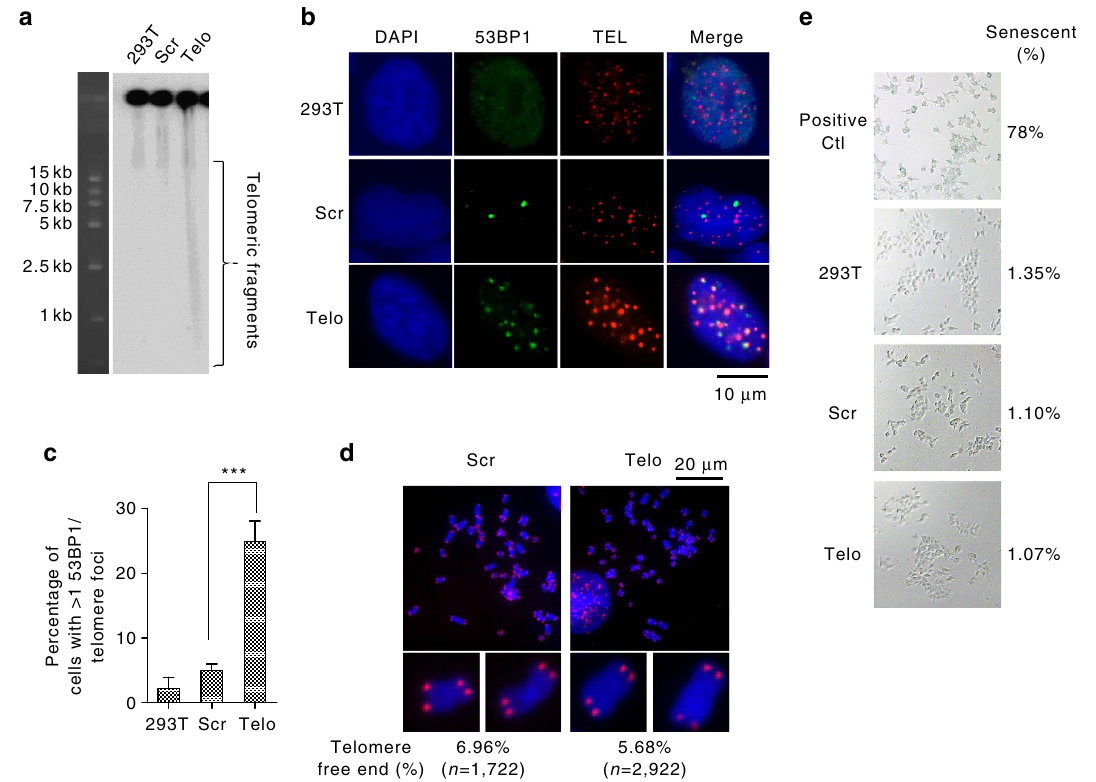
Figure 4 | Repair of CRISPR-Cas9-induced telomeric DSBs in 293Tcells. ( a ) DSBs were induced at telomeres by expression of telomeric sgRNA (Telo) in CRISPR-Cas9-transfected 293T cells. Scrambled sgRNA (Scr) was used as a control. DNA was isolated and analysed by CFGE as in Fig. 1c. ( b ) Immunofluorescence and FISH analysis was performed 24h after CRISPR-Cas9 transfection of 293T cells. Normal 293T cells and cells exposed to scrambled sgRNA (Scr) were used as controls. Scale bar, 10 m m.( c ) Quantification of b . The percentage of cells with one or more telomeric 53BP1 foci per cell was calculated. Values are the average ± s.d. of three independent experiments ( n Z 100). *** P o 0.001. The Student’s t -test was used to determine the statistical significance. ( d ) Telomere signal at chromosome termini determined using FISH. The percentage of chromosomes with one or more telomere- free ends was calculated, based on n ¼ 1,722 or 2,922 total chromosomes for Scr or Telo-sgRNA samples, respectively. Scale bar, 20 m m. ( e ) Cells treated as in b were analysed for SA- b -gal activity. Stress-induced 293Tsenescent cells were used as a positive staining control. Approximately 1,000 cells were counted and the percentage of senescent cells was